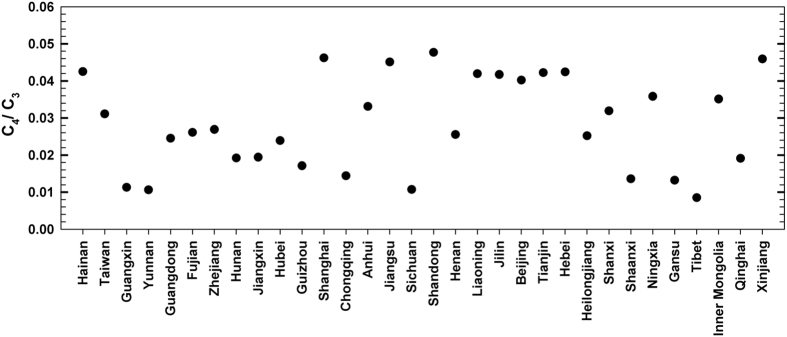
The C4/C3 fractions in 32 provinces and municipalities of China.